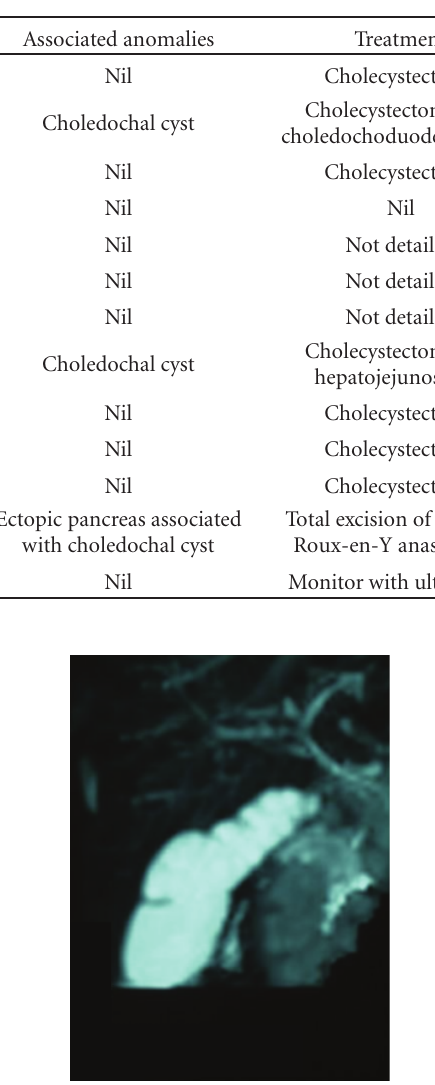
Figure 2: Magnetic Resonance cholangiopancreaticography (MRCP) image confirming ultrasound findings of multiple septae within the